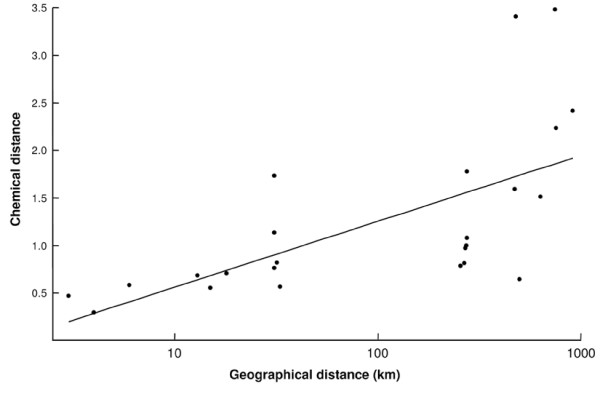
Correlation between pairwise geographic and chemical distances of populations of P. triangulum males. The trend line was obtained by linear regression in order to visualize the association (data sets 1 and 2; C25-type only; normalization: Würzburg – Düsseldorf; Mantel-test: r = 0.630, p = 0.013; see also Table 4 and text for details).